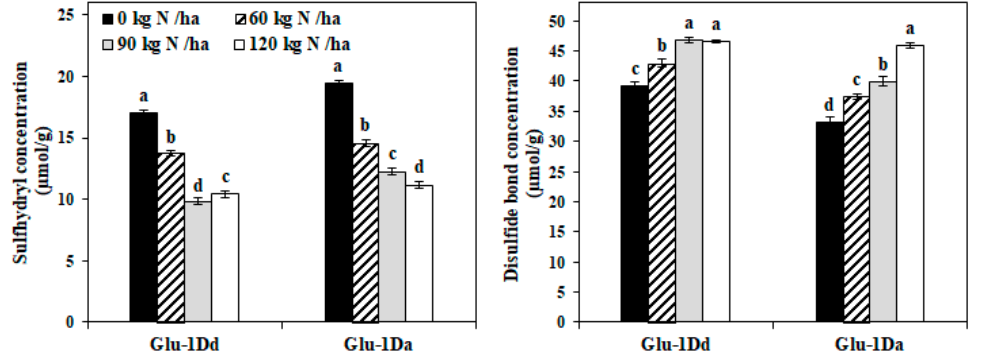
Figure 3. Concentration of sulfhydryl groups and disulfide bonds in lines with Glu-1Dd and Glu-1Da under N treatment. Same letter in the different columns for each material indicate no significant difference ( p > 0.05). Data are presented as the mean of two years.